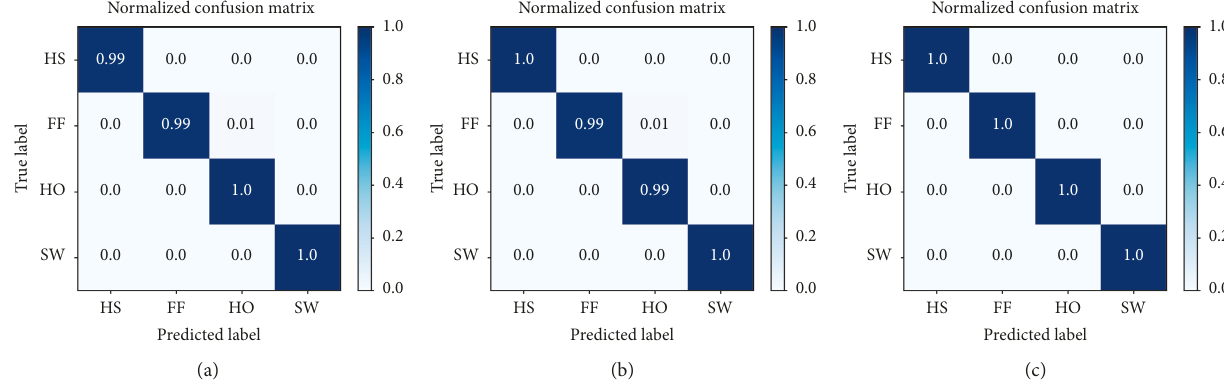
Figure 10: Confusion matrix of three gait patterns derived from VWI-DNN Classification under three pace settings: 0.78m/s (a), 1.0 m/s (b), and 1.25m/s (c)